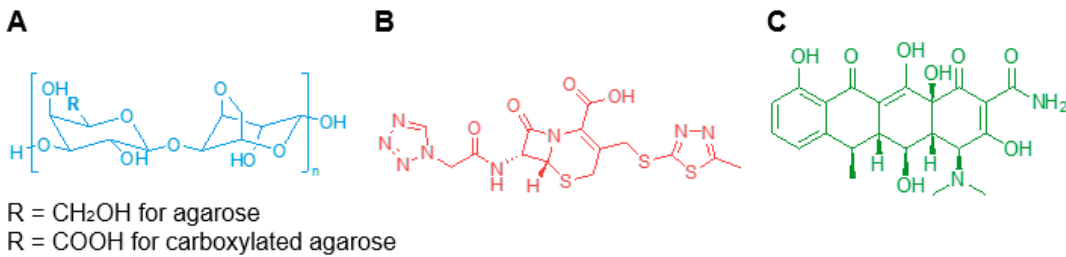
Figure 1. Chemical structures of ( A ) native and carboxylated agarose, ( B ) cefazolin, and ( C ) doxycycline.